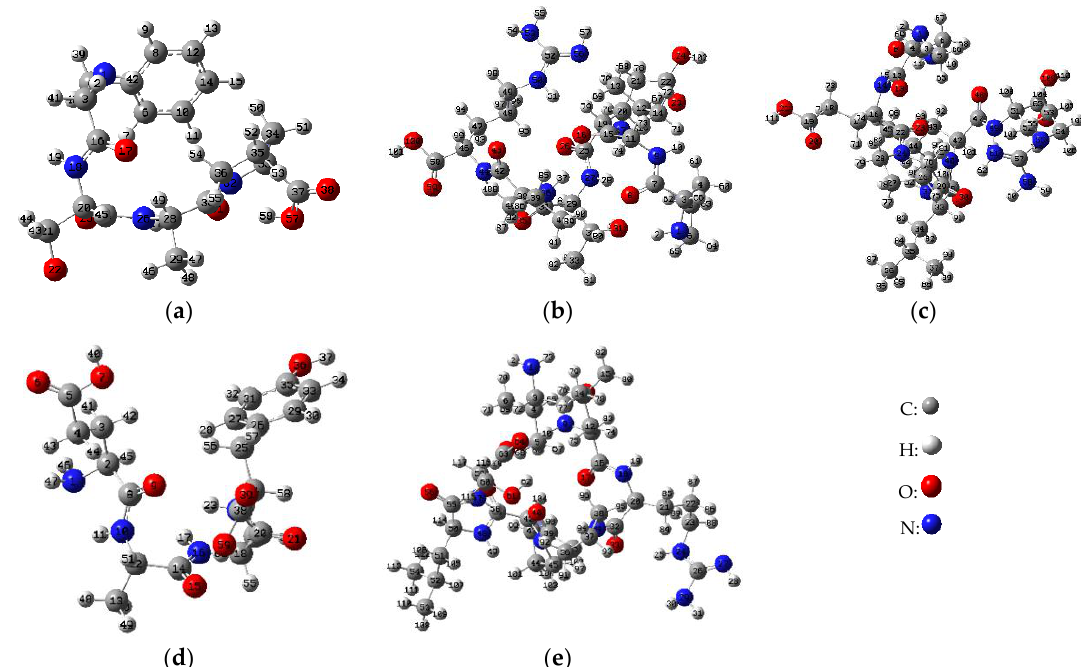
Figure 5. Optimized five peptides molecular structure with numbering of atoms and the atomic number of the molecule is derived from Gaussian 09 system. ( a ) to ( e ) are FSAP (Phe-Ser-Ala-Pro, 421.2082), PVETVR (Pro-Val-Glu-Thr-Val-Arg, 699.3915), QEPLLR (Gln-Glu-Pro-Leu-Leu-Arg, 754.4337), EAAY (Glu-Ala-Ala-Tyr, 452.1907) and VLRPPLS (Val-Leu-Arg-Pro-Pro-Leu-Ser, 780.4857), respectively. Table 2. Partial natural charge distribution of the five peptides was analyzed by natural bond orbital (NBO).